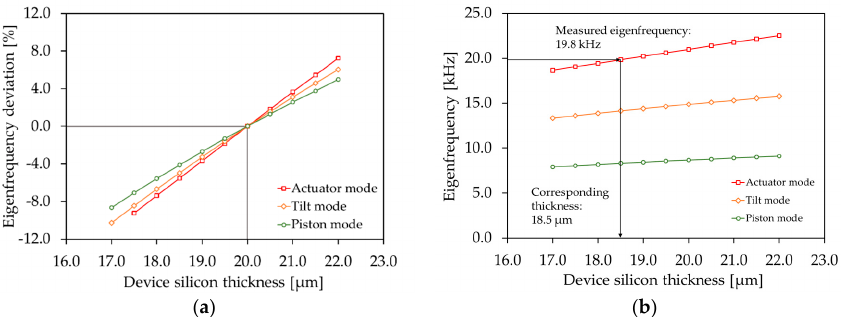
Figure 4. Simulated influence of the device silicon thickness on the eigenfrequency (Design 1): ( a ) eigenfrequency deviation (deviation with respect to the eigenfrequency at 20 µm) versus device silicon thickness; ( b ) eigenfrequency versus device silicon thickness.